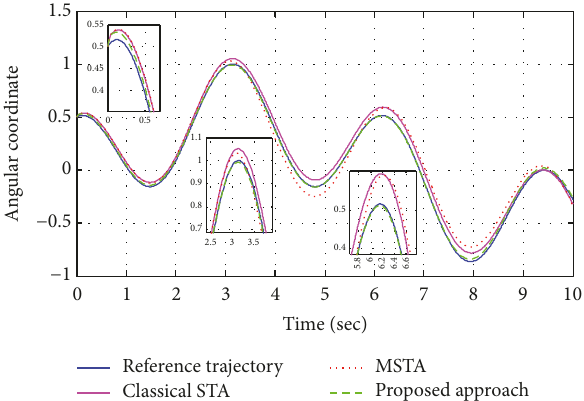
Figure 3: The response 𝑥 1 (𝑡) of the system with matched and unmatched uncertainties.